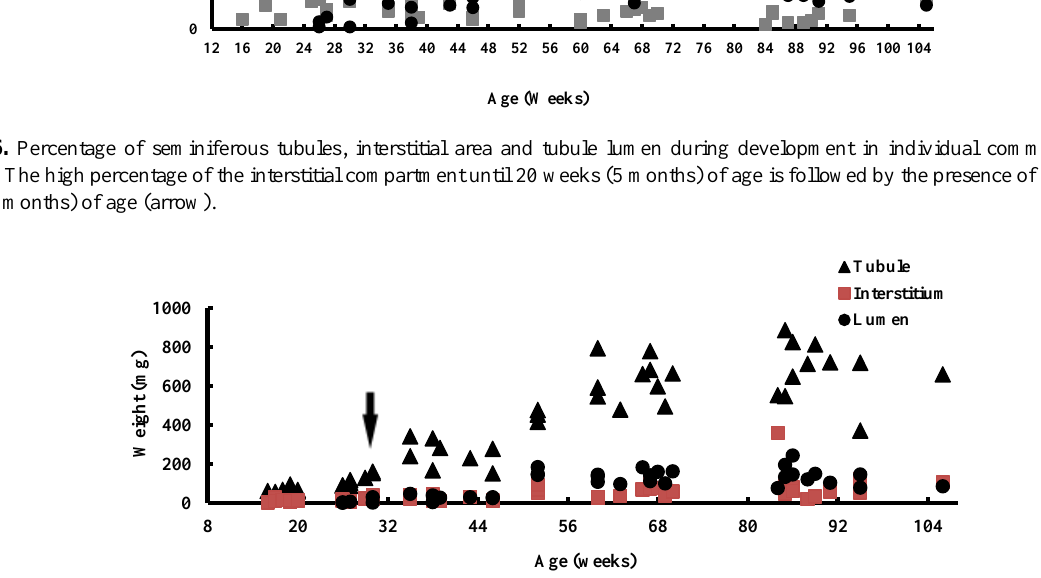
Figure 7. Calculated weight of seminiferous epithelium, interstitial area and the tubule lumen during development in the individual common marmosets ( n = 48). The rapid increase in the tubular weight was observed after 30 weeks of age